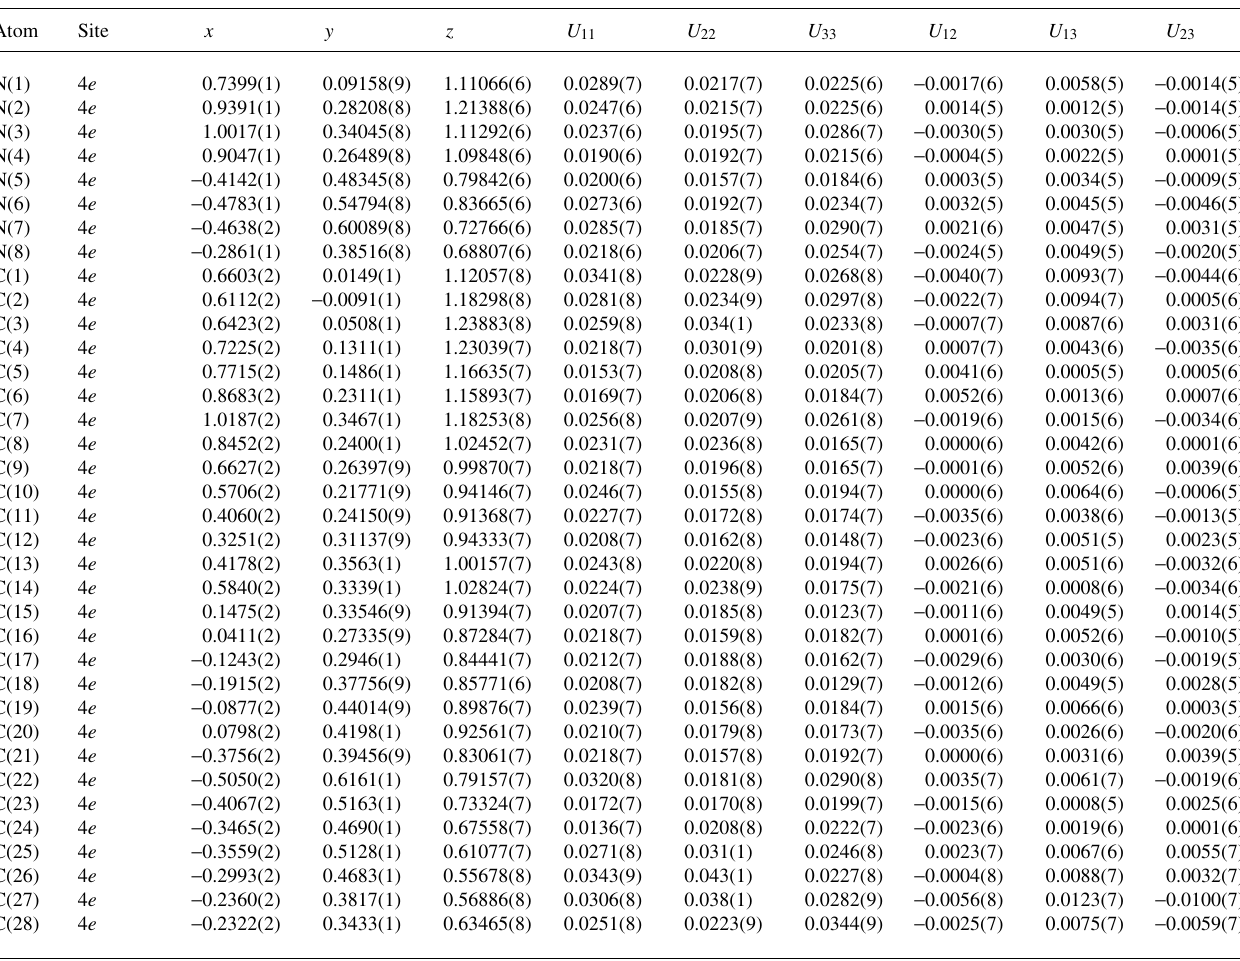
Table 3. Atomic coordinates and displacement parameters (in Å 2 )